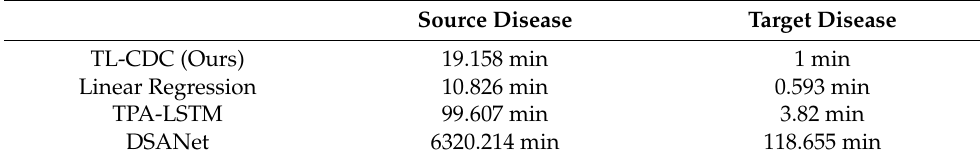
Table 7. Training Time of Prediction Model for Disease Course.